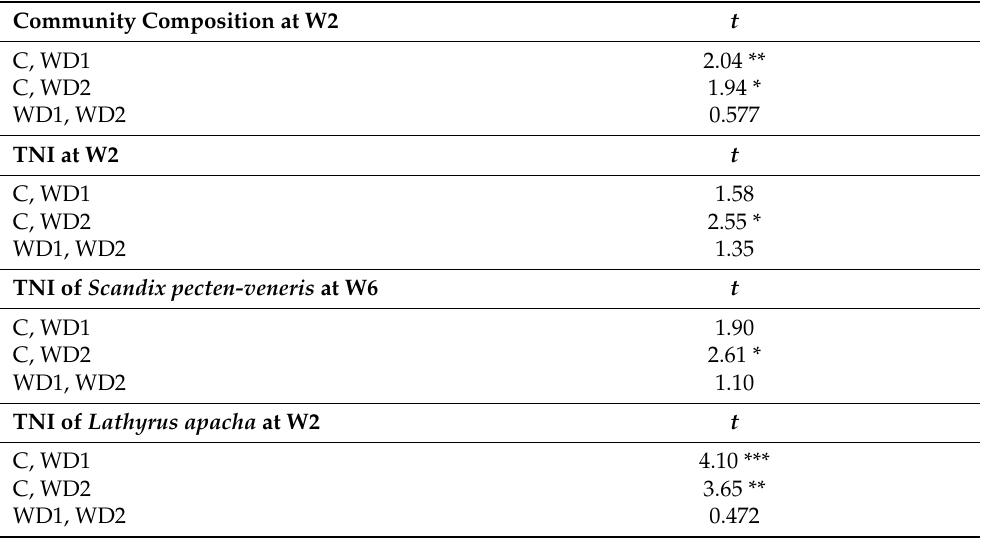
Table 2. Results of PERMANOVA pairwise t -tests (number of individuals) between treatments; TNI = total number of individuals; C = 0% wood distillate; WD1 = 0.2% wood distillate; WD2 = 0.5% wood distillate; W2 = week 2; W6 = week